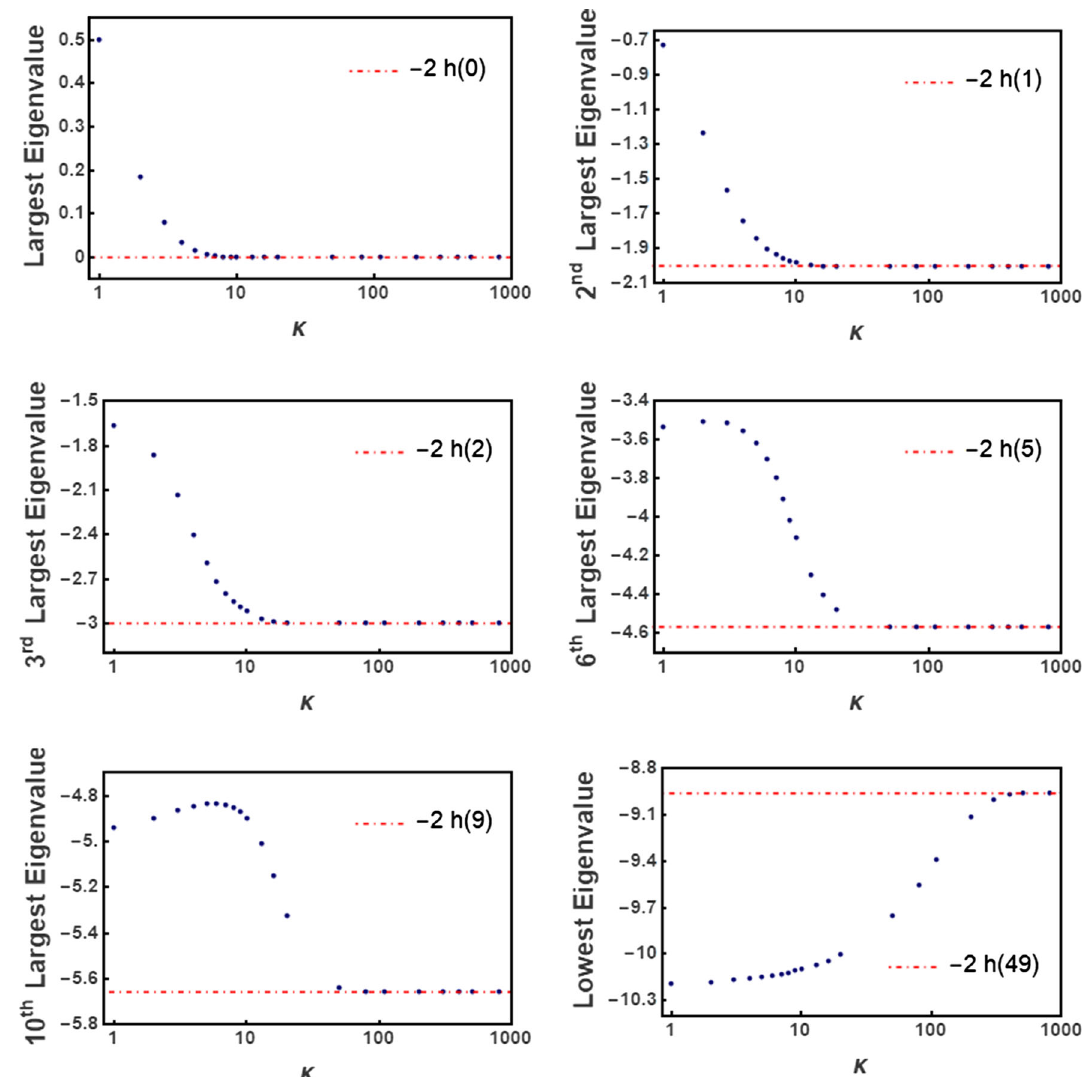
Fig. 14 Spectrum for a matrix size of N = 50 as κ increases